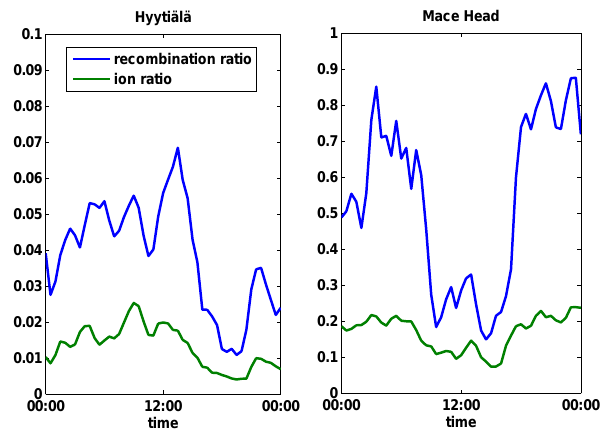
Fig. 5. Median fraction of ions from all measured particles in the size range 1.3–3nm (ion ratio) and the fraction of recombination products from neutral nano-CN (recombination ratio).